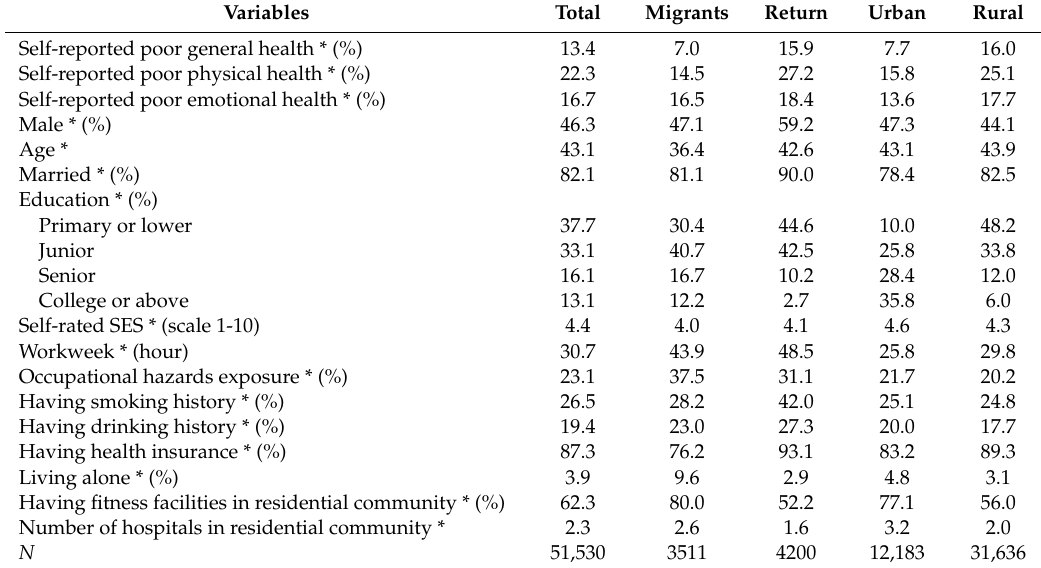
Table 1. Percentages and means of variables by migration status: China Labor-force Dynamics Survey (CLDS) 2012–2016. Variables Total Migrants Return